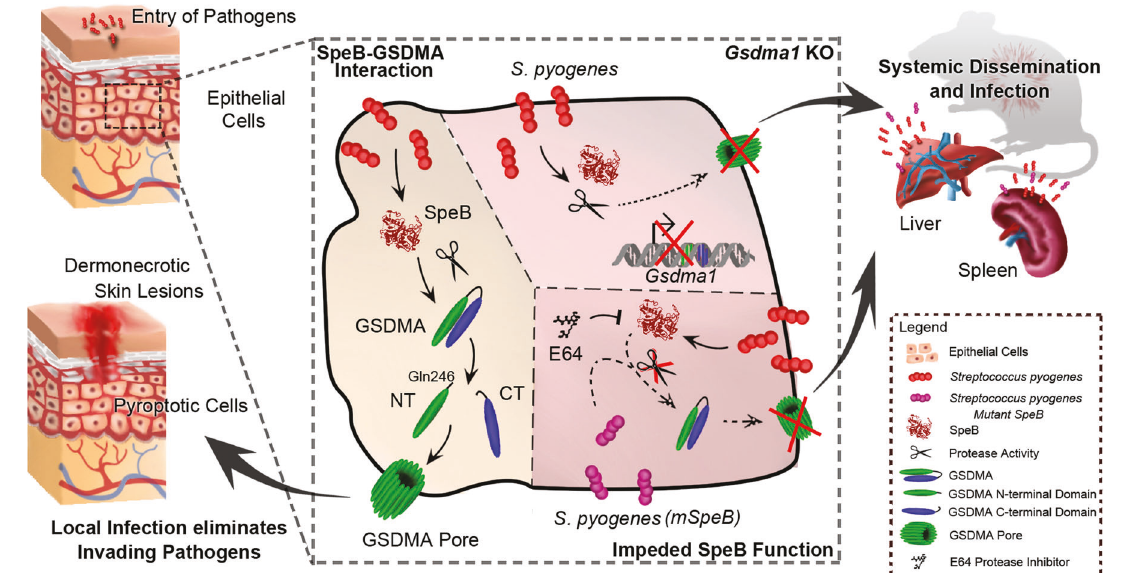
Fig. 1 GSDMA-driven pyroptosis of epithelial cells as a single-molecule mechanism for detection and elimination of SpeB-expressing Streptococcus pyrogenes . Following pathogen invasion, caspase 1-independent activation of the gasdermin GSDMA occurs via direct proteolytic cleavage by SpeB. Subsequent GSDMA pore formation in the host cell membrane promote pyroptosis of the infected cells, ultimately leading to local in fl ammation and elimination of the pathogen. Gsdma1 de fi ciency and SpeB mutation/inhibition fail to result in activated GSDMA and thus the local immune response, resulting in systemic dissemination and infection of multiple organs. SpeB protein structure was designed by Universal Protein Resource (UniProtKB accession number